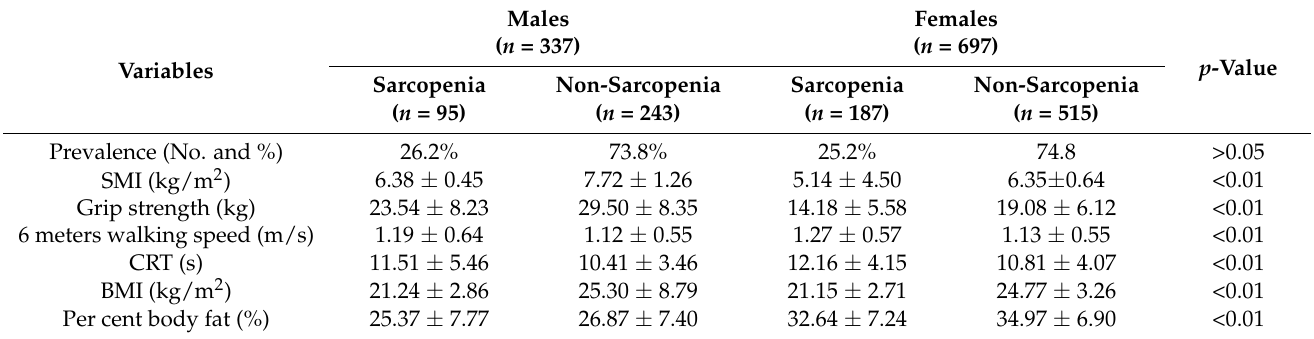
Table 3. Comparison of elderly-related indicators among different genders ( n =